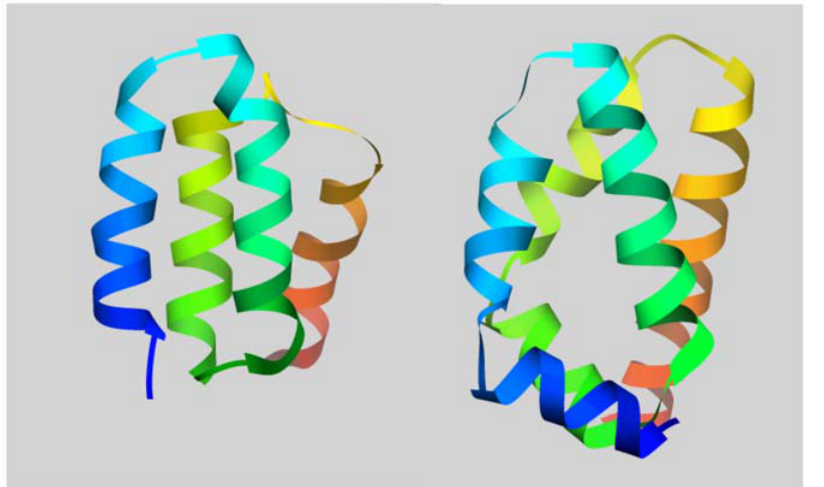
Figure 1. Archetypal HEAT and ARM repeats. The examples of repeat pairs shown correspond well to the described archetype. Left: HEAT (PDB:1w63A), residues 376–499; right: ARM (PDB:1ialA), residues 366–455. Images were rendered with USCF Chimera [33]; The structure are rainbow- coloured from N-terminus (blue) to C-terminus (orange).